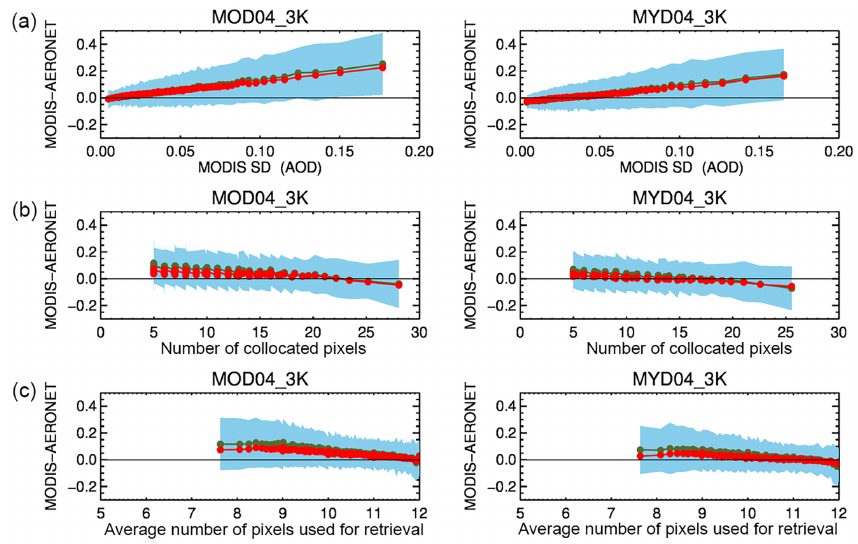
Figure 7. Same as Fig. 6 except for standard deviation of MODIS AOD within the 5 × 5 collocation box (a) , number of MODIS retrievals with the 5 × 5 collocation box (b) , and number of MODIS reflectance native pixels used by the retrieval, averaged for all retrievals made in the 5 × 5 collocation box (c) .